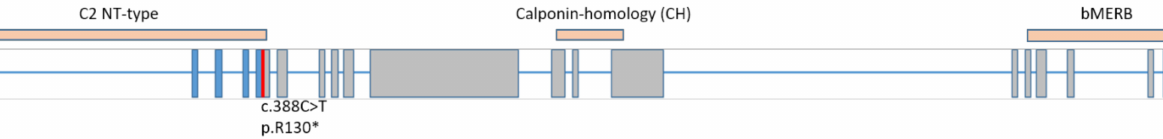
Figure 2. Structure of the EHBP1L1 gene and site of the mutation. All 19 exons are filled in gray or blue. The premature stop codon mutation in exon 5 is marked by a red line. The wild-type protein will contain 19 exons (i.e., all blue and gray exons), while the mutant protein, if produced, would contain only exons 1–4 and part of exon 5 (i.e., the blue ones). The locations of the predicted homology domains, in reference to the human EHBP1L1 protein, are also indicated. A comparative amino acid sequence analysis determined a 70.3% identity between the canine and human